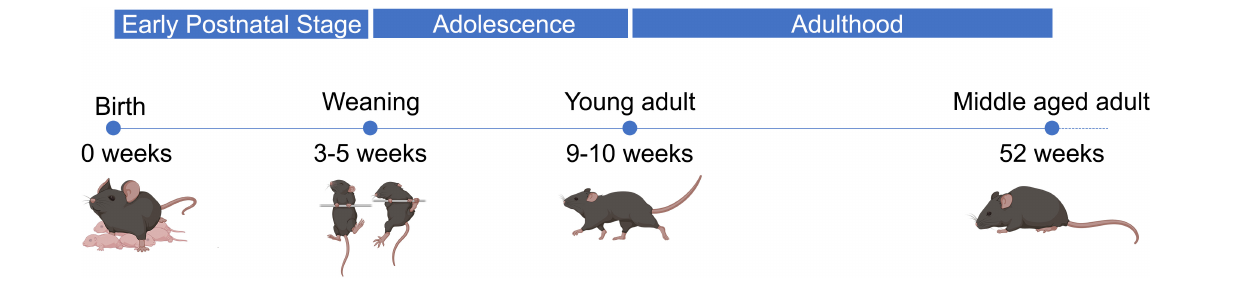
across time for the glycolytic muscle tissues i.e., EDL, TA, gastrocnemius, and quadriceps (rho < − 0.63; p < 0.05) ( Figures 3F,H–J ). By contrast, the relative miR-206